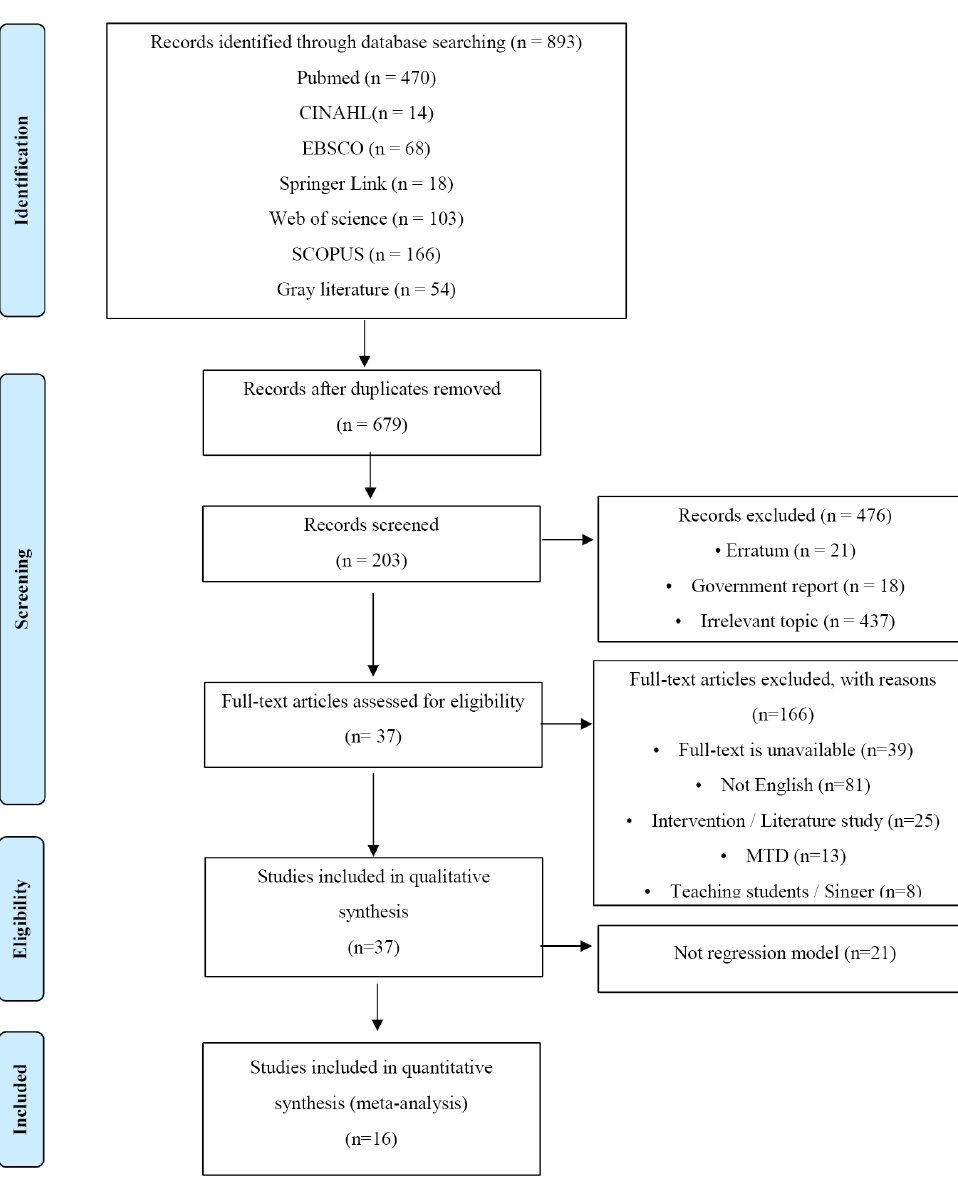
Figure 1. PRISMA flow diagram.